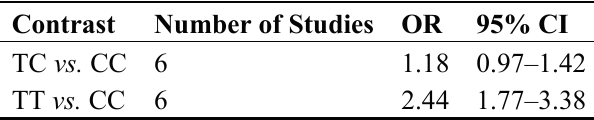
Table 4. Multivariate meta-analysis for the 226 C>T (Ala57Val) polymorphism of the CD24 gene with